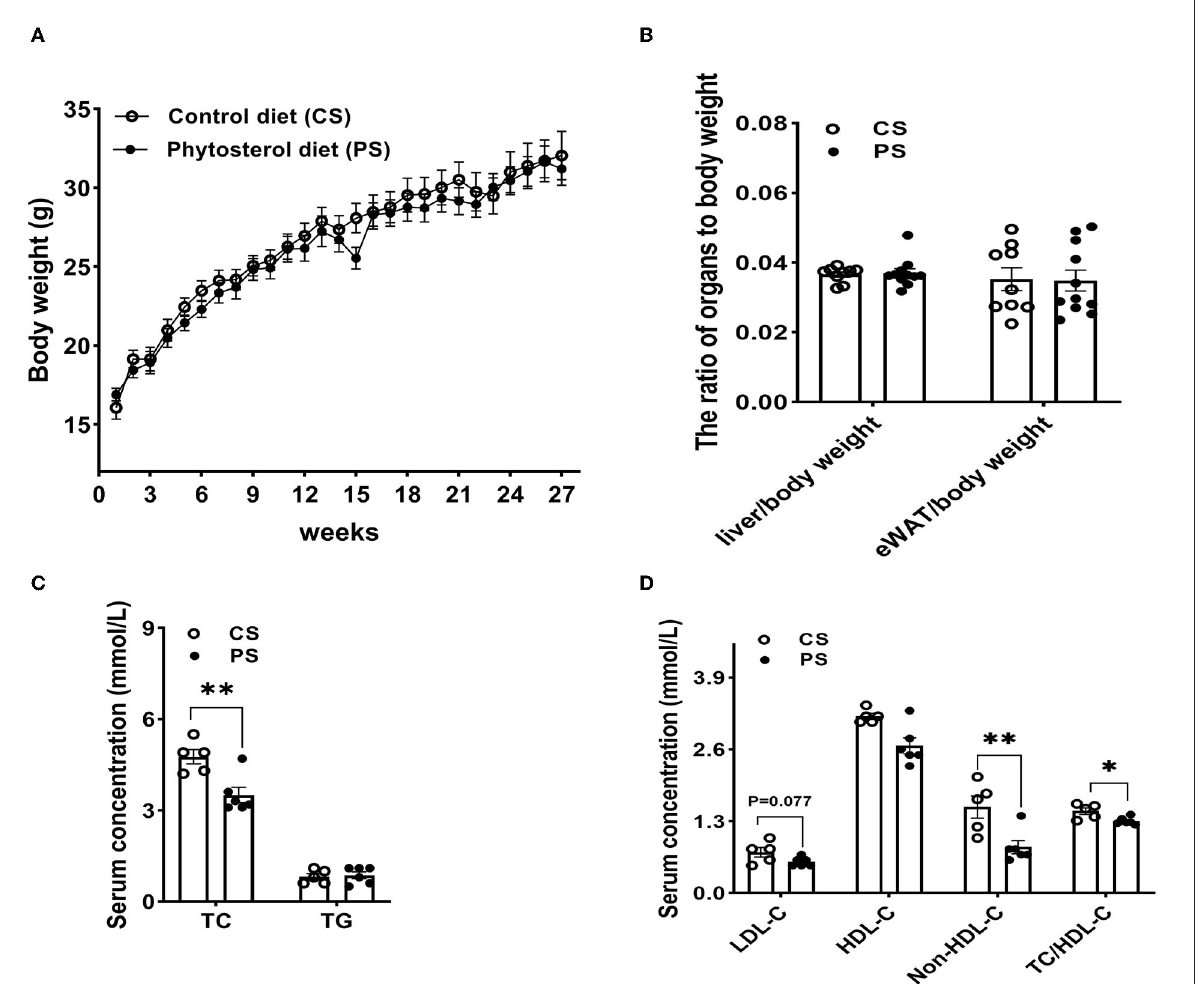
FIGURE2 Weight and biochemical indicators. (A) Body weight. (B) Liver to body weight ratio and eWAT to body weight ratio ( n = 9–11 mice/group). (C) Serum TC and TG levels ( n = 5–6 mice/group). (D) LDL-C, HDL-C, non-HDL-C concentrations and TC/HDL-C ( n = 5–6 mice/group). Results are the mean ± SEM. * p < 0.05, ** p <